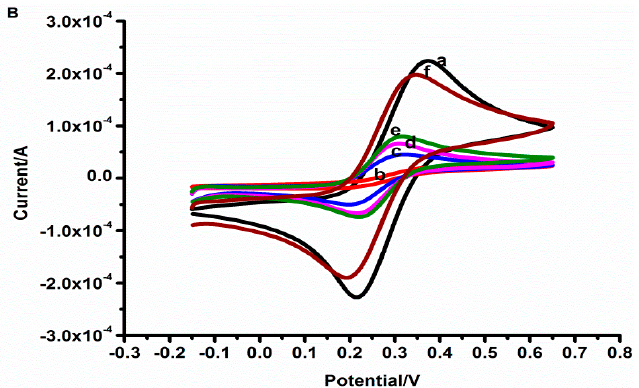
Figure 3. ( A ) Impedance plots of: bare electrode (a), CG / GCE (b), TH-CG / GCE (c), Au-TH-CG / GCE (d), Apt-Au-TH-CG / GCE (e), tau381-Apt-Au-TH-CG / GCE (f) in 10 mM [Fe(CN)6] 3 − / 4– (1:1 ratio). In the inset, Rs, W, Ret, and CPE stand for the solution resistance, the Warburg di ff usion resistance, the electron-transfer resistance, and the double layer capacitance, respectively. ( B ) Cyclic voltammetry of Fe(CN)6] 3 − / 4 − for: bare electrode (a), CG / GCE (b), TH-CG / GCE (c), Au-TH-CG / GCE (d), Apt-Au-TH-CG / GCE (e), tau381-Apt-Au-TH-CG / GCE (f) in 0.1M PBS (pH 7.0) containing 10 mM [Fe(CN)6] 3 − / 4– (1:1 ratio).